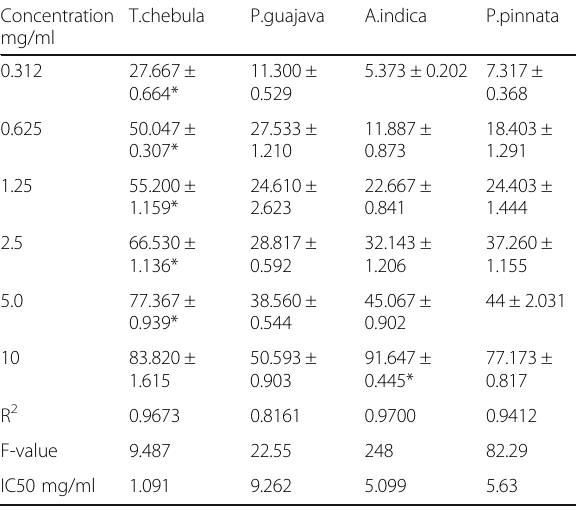
Table 2 Gtf inhibitory effect of different plant extracts at various concentrations